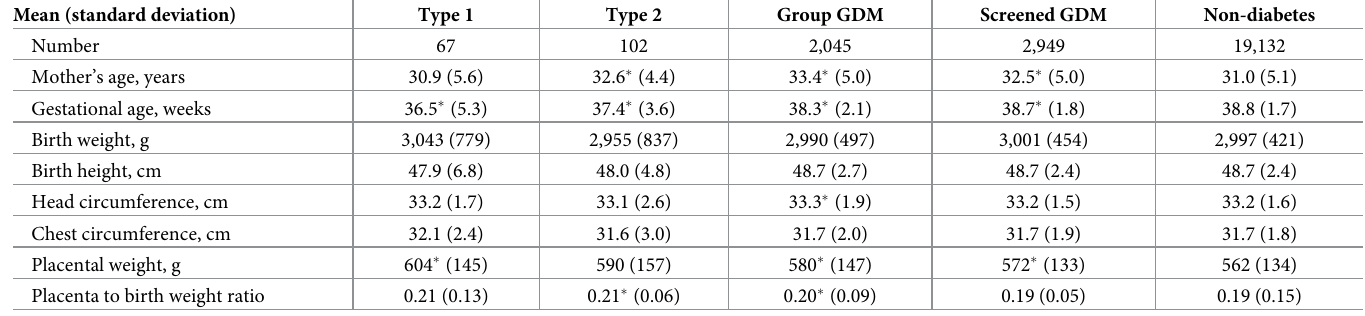
Table 1. Anthropometrics of neonates of mothers with various types of diabetes and those without diabetes.